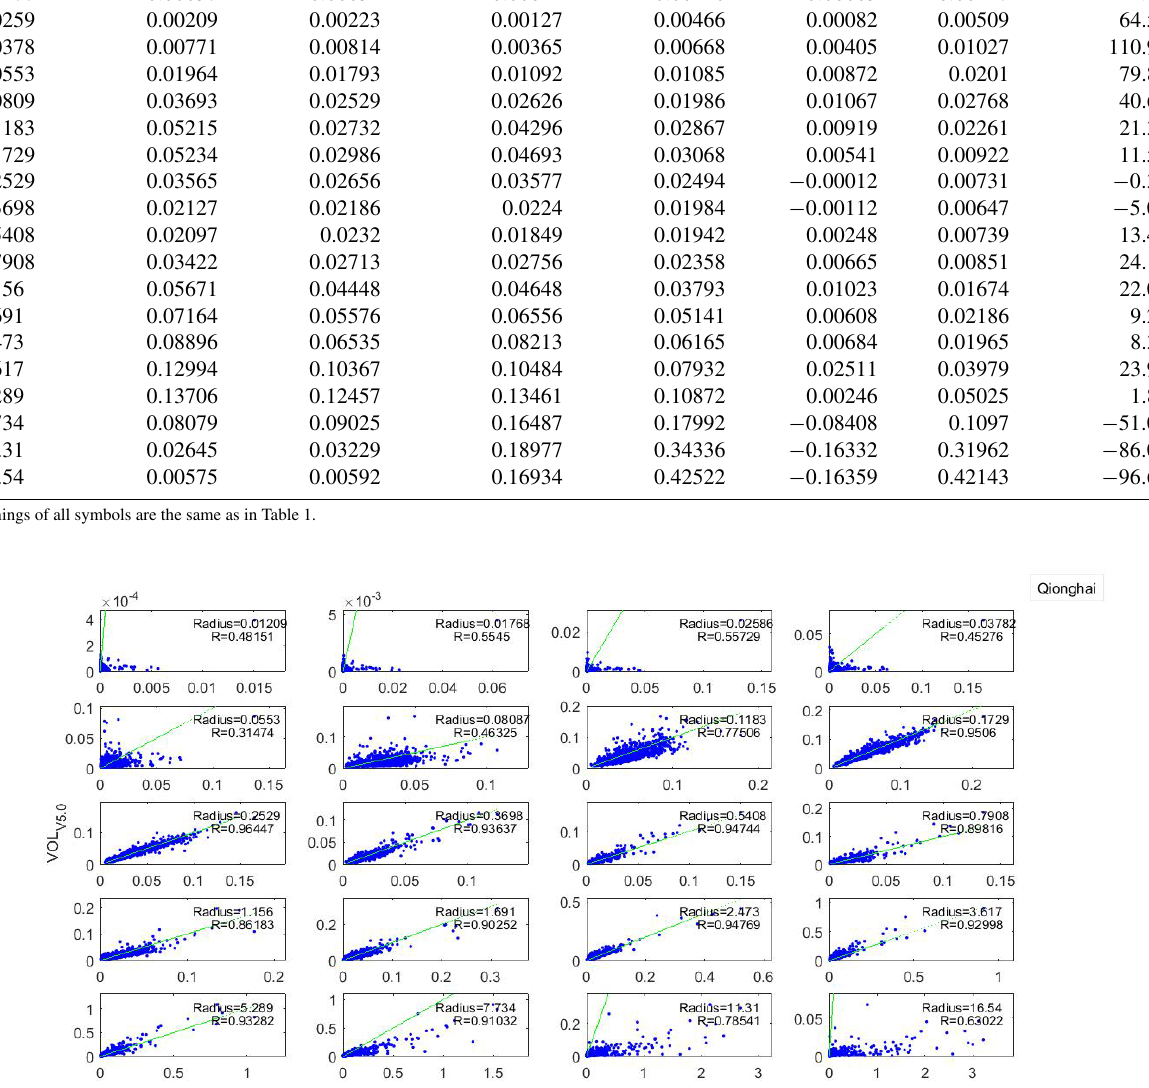
0.96, 0.94, and 0.91 with those from V4.2 at